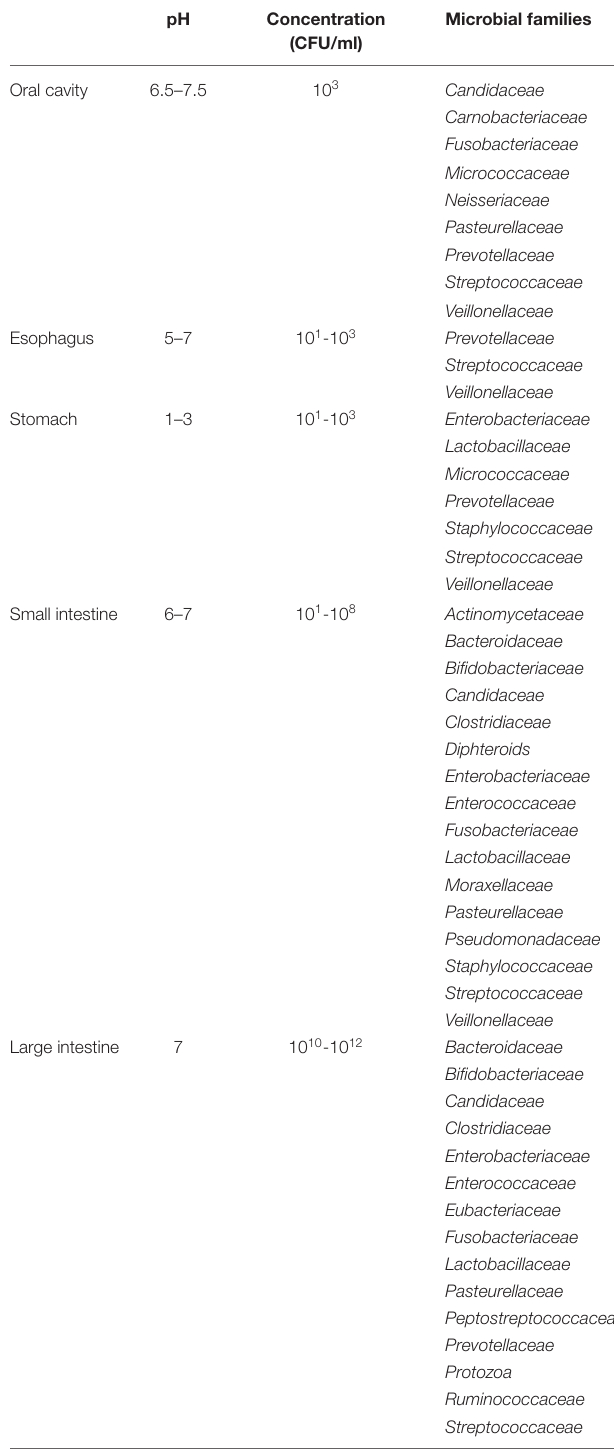
The main microbial families are listed here (in alphabetical order) according to their distribution along the gastrointestinal (GI) tract, with differences in terms of microbial concentration (shown in the third column) and in relation to the pH of the different GI areas (displayed in the second column). CFU, colony-forming